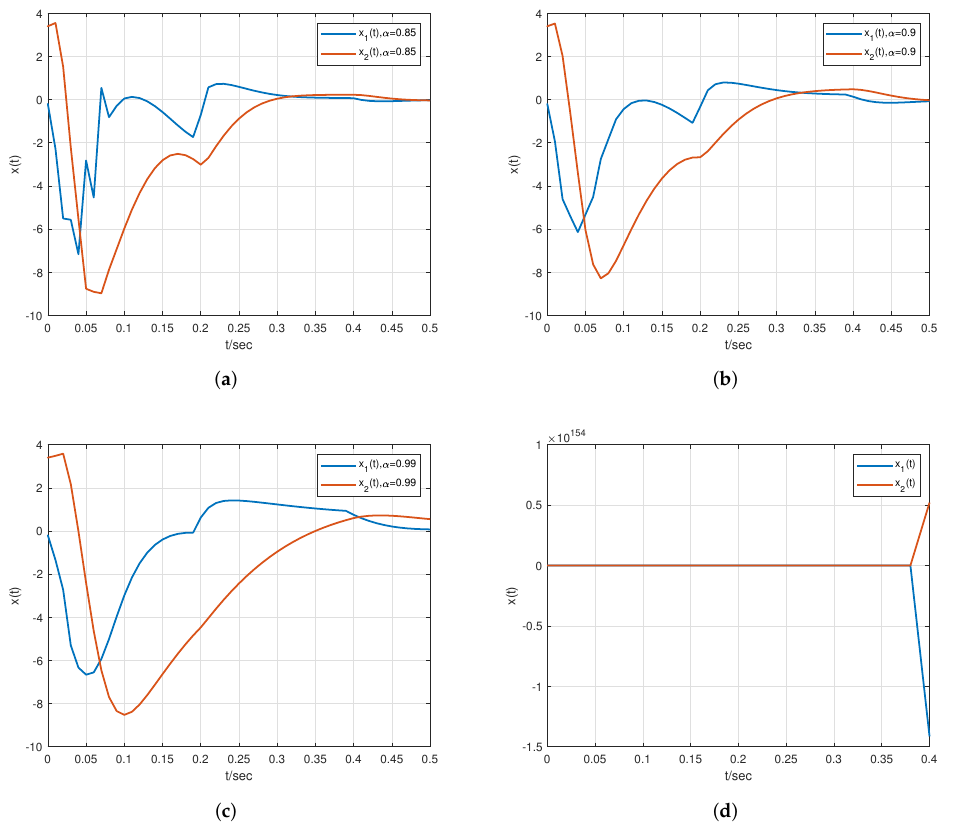
Figure 5. The panels ( a – c ) contain the curves of state variable x 1 ( t ) and x 2 ( t ) for mixed H ∞ and Passivity performance with distinct FO circumstances α = 0.85,0.9,0.99. Moreover, panel ( d ) is the trajectories of the open loop system in Example